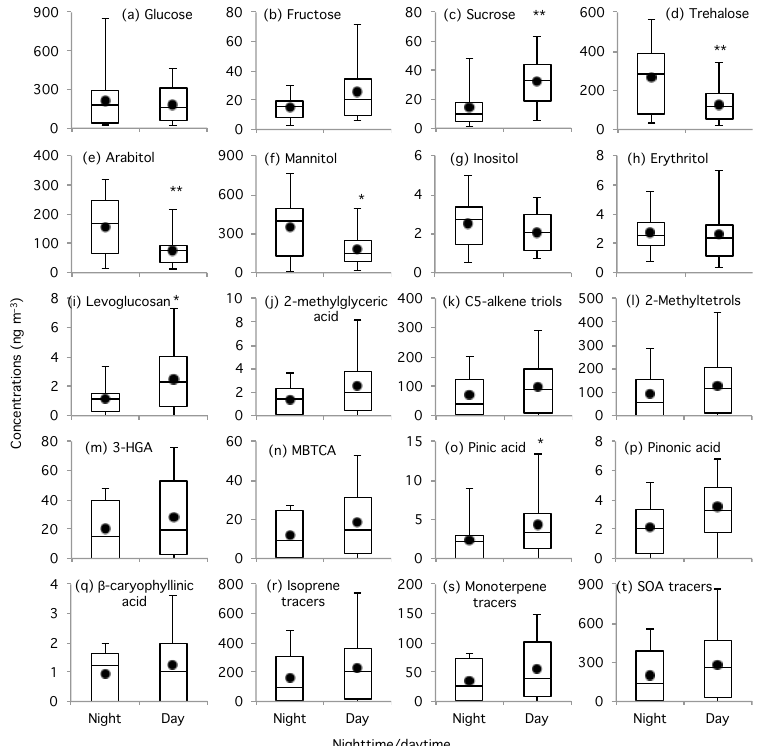
Figure 1. Diurnal variations of organic compounds in forest aerosols in Wakayama, Japan during 20–30 August 2010. The 10th, 25th, 50th, 75th and 90th percentiles of the nighttime and daytime samples were shown in the box-and-whisker plot. The means were shown in solid circles. Statistically significant values were also shown ( t test, ∗ p < 0 . 05; ∗∗ p < 0 .